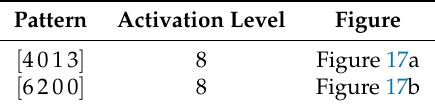
Figure 16. Experimental hardware setup. Table 2. Experimental actuation